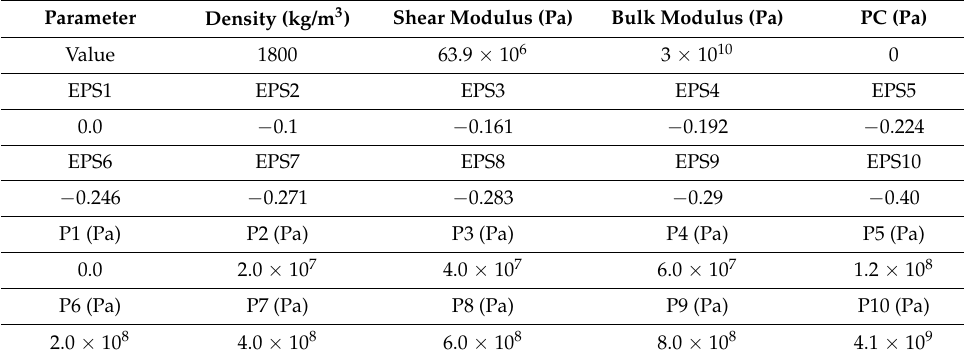
Table 6. Material parameters of the soil